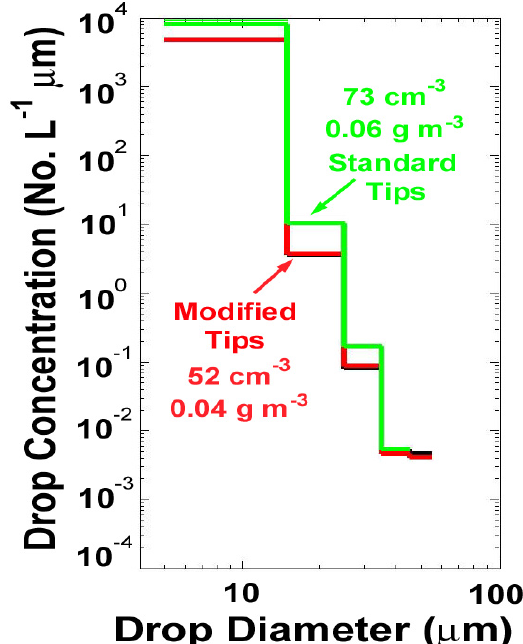
Fig. 4. 2D-S size distributions from Learjet penetration (20:54:08 Figure 4. 2D-S size distributions from Learjet penetration (205408 205421 UTC on 23 July to 20:54:21UTC, 23 July 2010) of a small cumulus cloud contain- 2010) of a small cumulus cloud containing only water drops. The light green trace is from the ing only water drops. The light green trace is from the probe with probe with standard tips and includes shattered particles. A dark green trace is from the standard tips and includes shattered particles. A dark green trace is from the probe with standard tips after applying the shattering algo- rithm, but is not visible behind the light green trace. The red trace is from the probe with modified tips and includes shattered particles. A blue trace from the probe with modified tips after applying the shattering algorithm is barely visible near the red